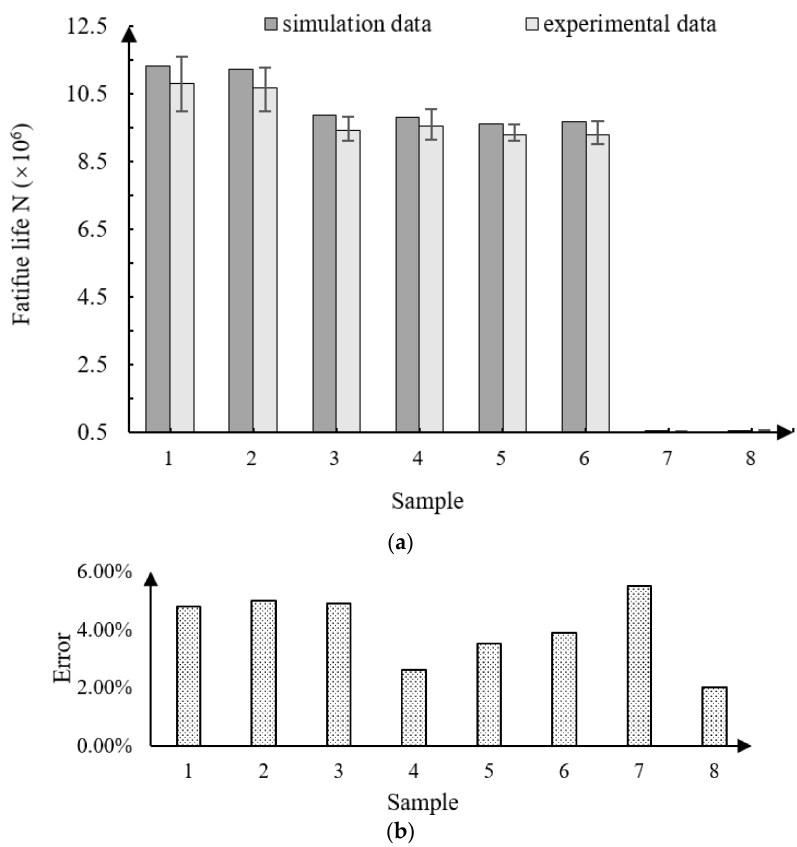
Figure 11. Simulation data and experimental data error. ( a ) Comparison of simulation data and experimental data; ( b ) error between simulation data and experimental data.